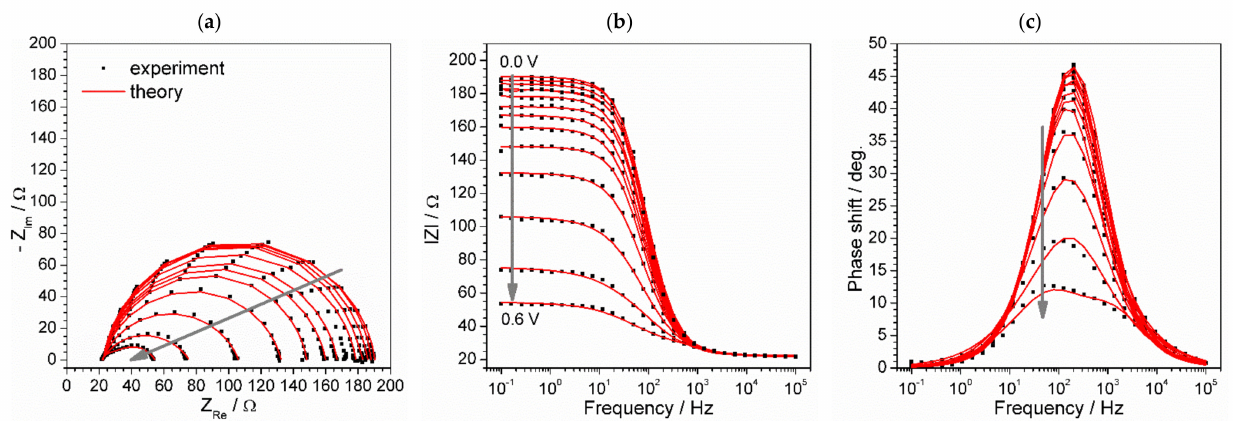
Figure 4. Equivalent circuit fitting results of a set of impedance spectra obtained for a solar cell based on TiO 2 NPs electrode sensitized with AC-9 dye: ( a ) complex plane (Nyquist) plot, ( b ) impedance module, and ( c ) phase shift dependence on frequency (Bode plot). The grey arrows indicate spectra change with voltage increase.